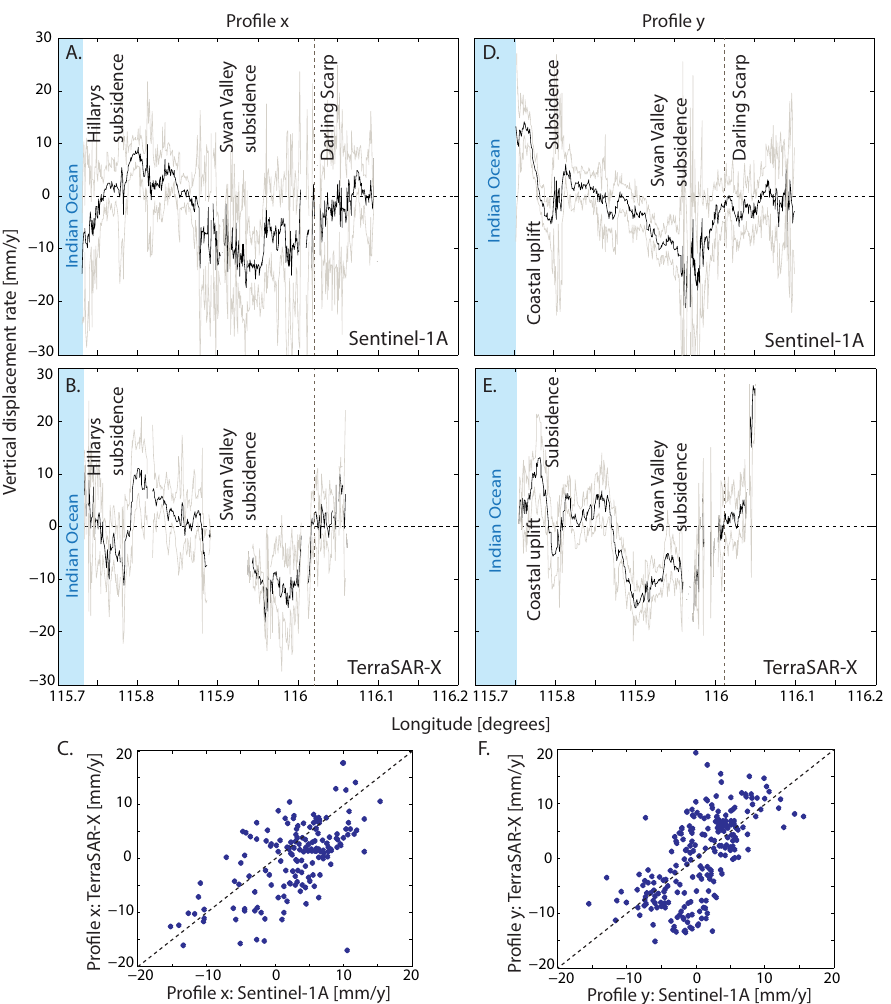
Figure 5. Profiles of average displacement rate corresponding to the lines labelled profile x ( A – C ) and profile y ( D – F ) in Figure 4. The top panels (A,D) are profiles through Sentinel-1A data, and the middle panels (B,E) are through TerraSAR-X data. Profiles and errors (grey lines) are calculated using a band 10 pixels wide and the method described in Section 4.4. Profile x shows a broad region of subsidence, whereas profile y reveals adjacent subsidence and uplift as identified in the rectangle in Figure 4. (C,F) show the correlation between the measurements from the two satellites along profiles x and y, respectively. The dashed black line shows a 1:1